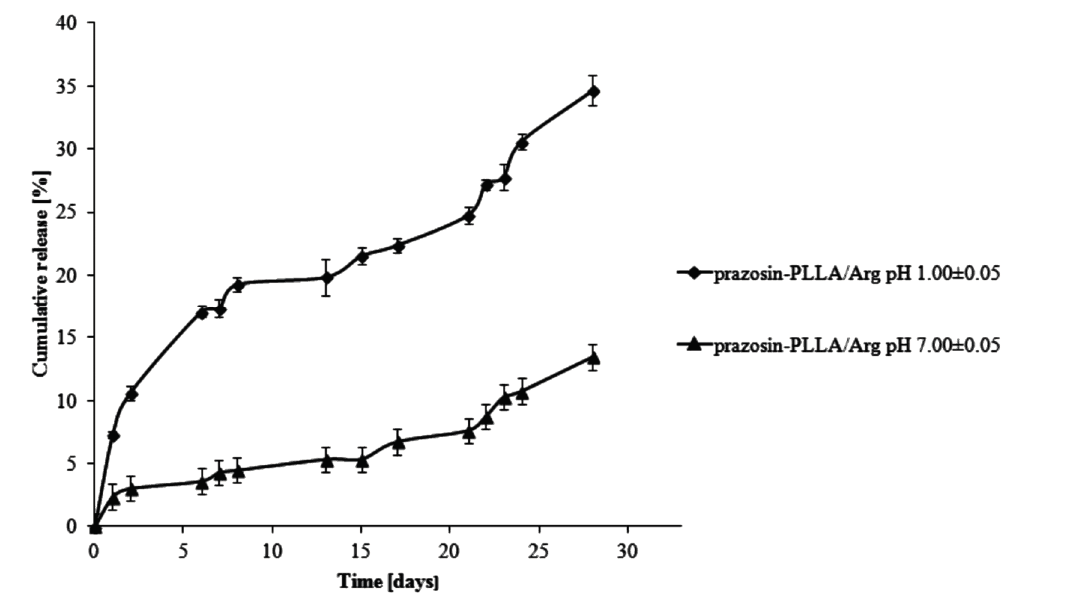
Figure 5. Release profile of prazosin from the prazosin–PLLA/Arg conjugate (pH 7.00 ± 0.05 and pH 1.00 ± 0.05).